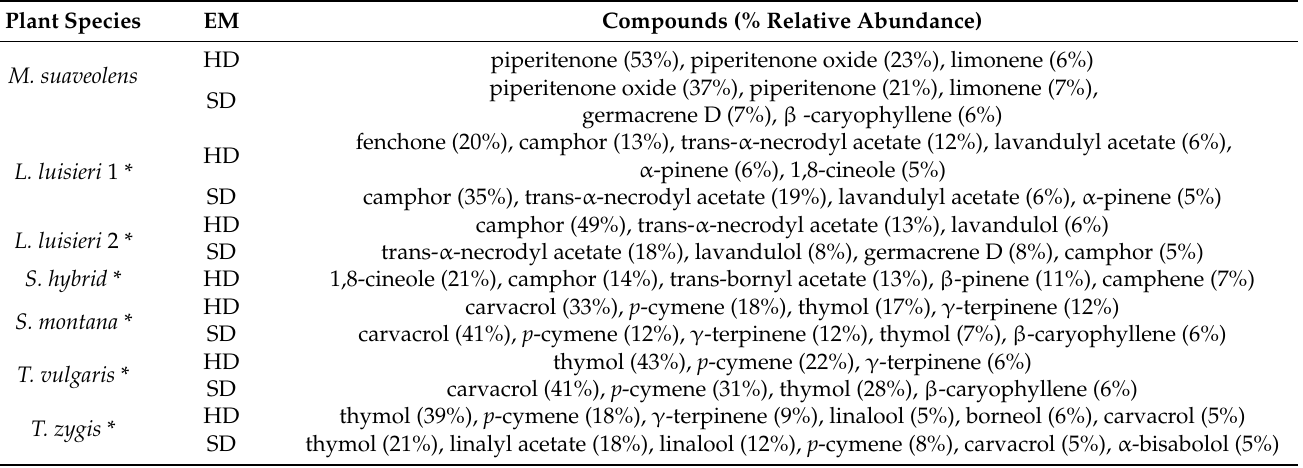
Table 2. Main components of the EOs from the most active species (abundance ≥